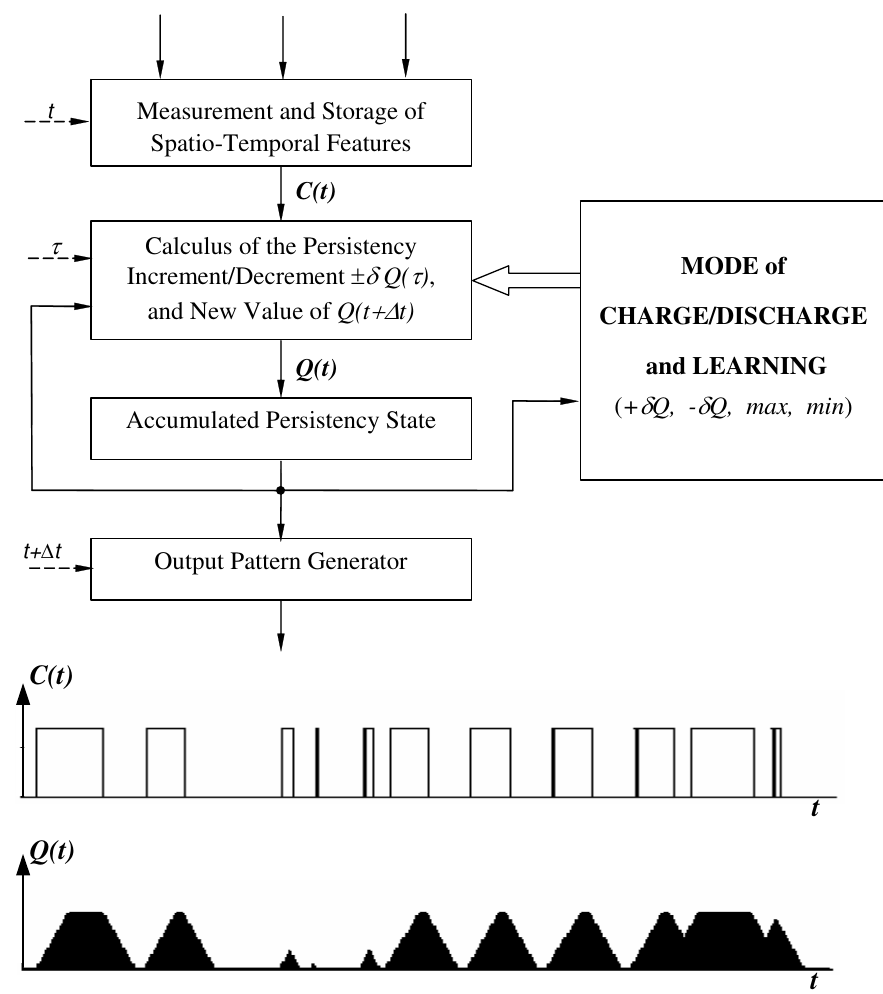
Figure 1. The AC working memory model (upper part) and an example of the temporal evolution of the accumulated persistency state, Q ( t ) , in response to a specific sequence of input values (lower